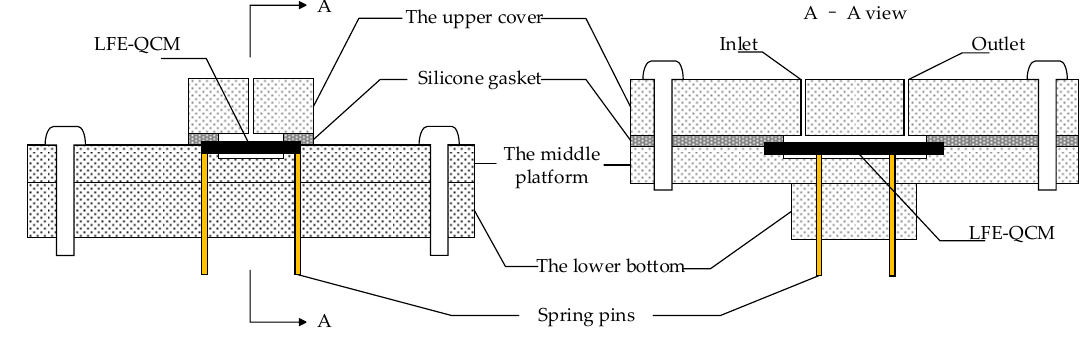
Figure 4. The flow cell structure diagram.